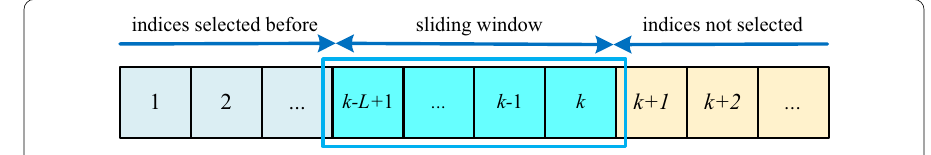
Fig. 2 An example of the sliding